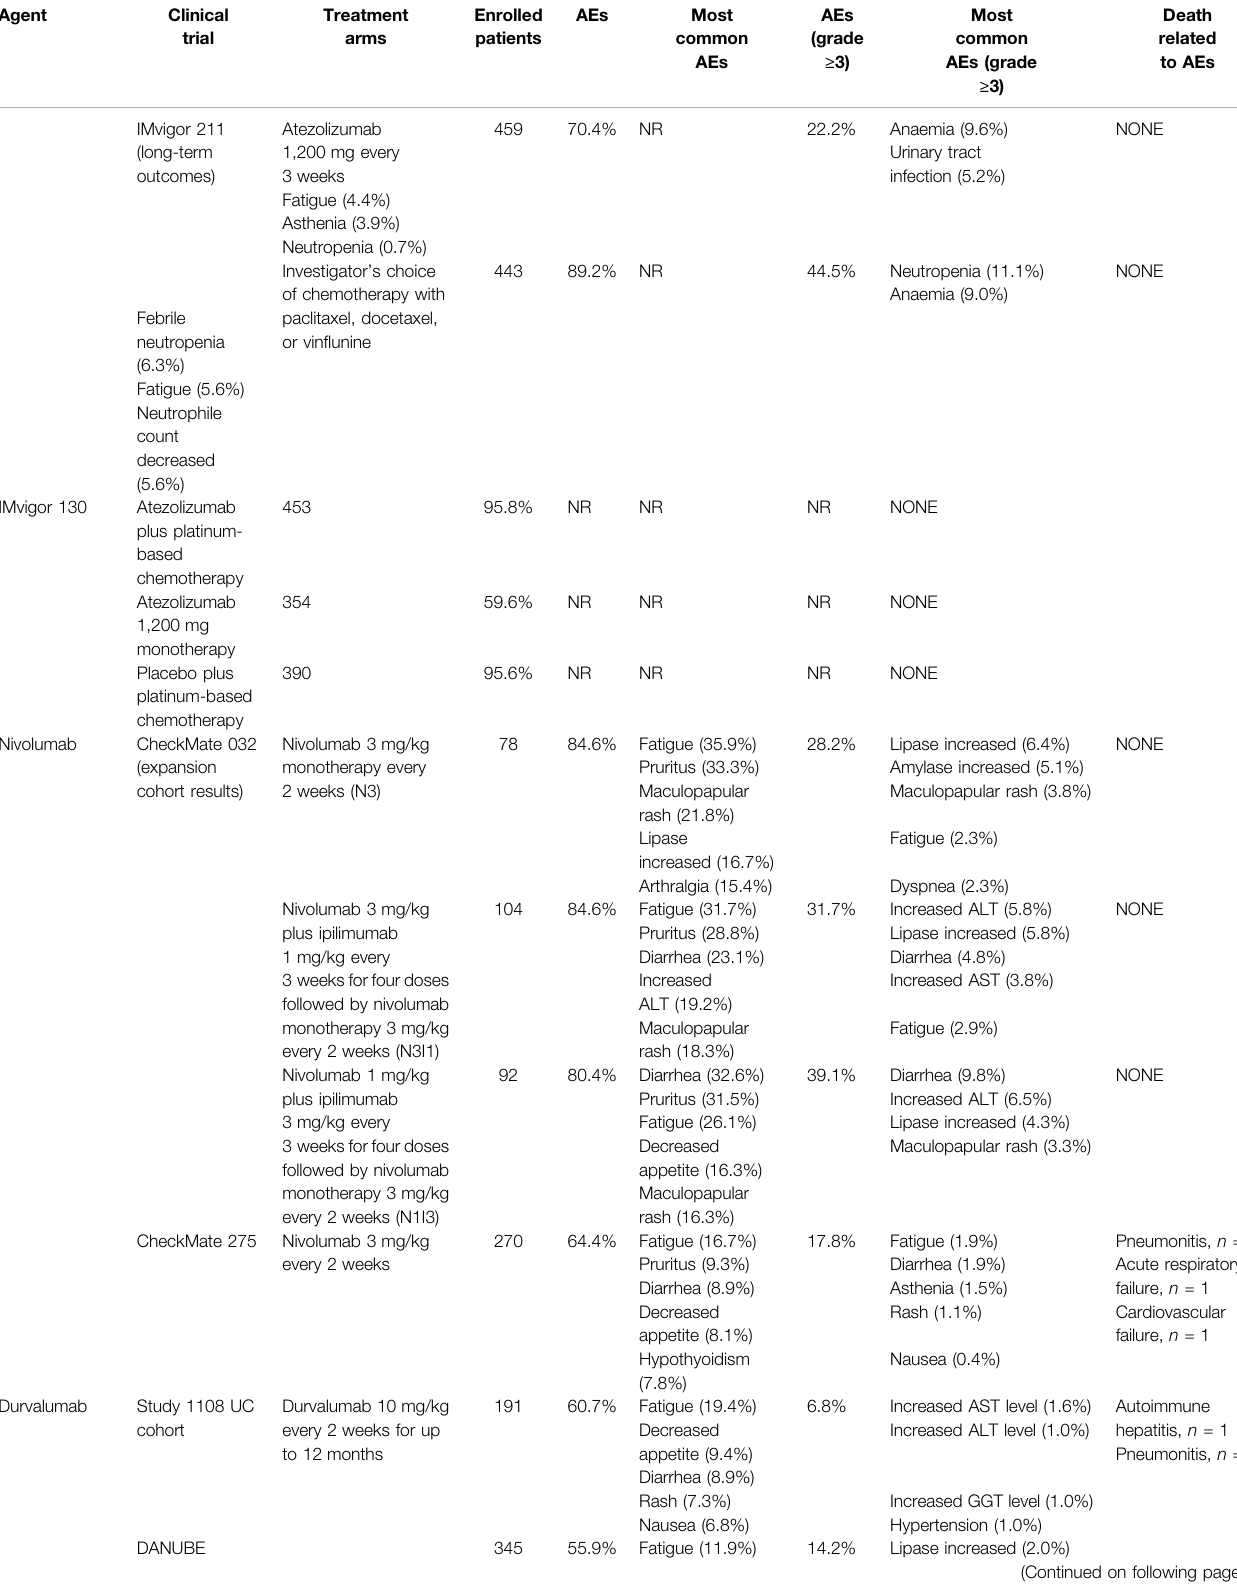
TABLE 3 | ( Continued ) Key clinical trials ’ safety data of ICIs in patients with